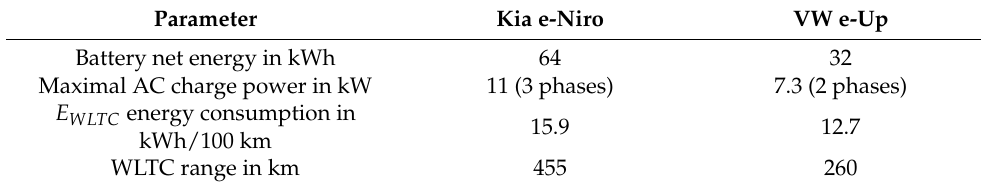
Table 3. Relevant vehicle data.